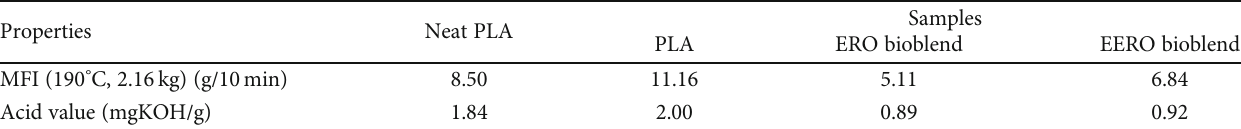
Table 5: The MFI and acid value of neat PLA and samples.